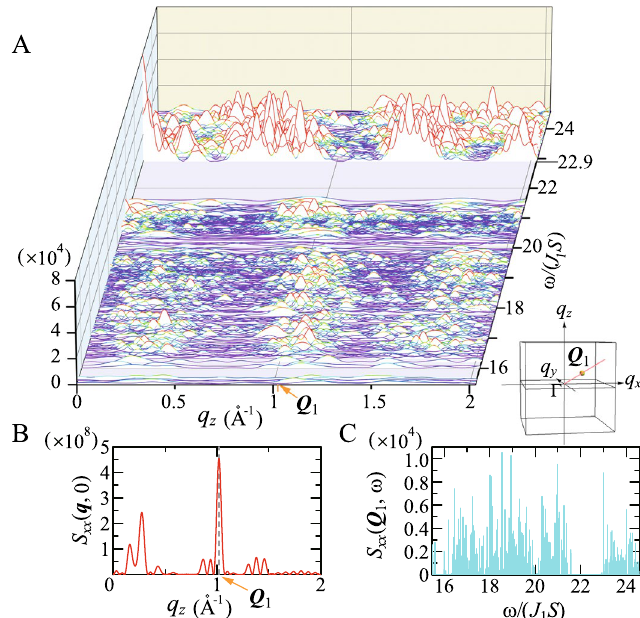
Figure 3. Dynamical structure factors ( A ) S xx ( q , ω) and ( B ) S xx ( q , 0 ) for q along the d ∗ e 2 line through Q 1 with Q 1 inside the cube with a side length of 2 3.54 Å − 1 . ( C ) The ω q y 0 . Inset illustrates the d ∗ e 2 line through × = Q 1 dependence of S xx ( Q 1 , ω) . The dashed line in ( B ) is the guide for q =